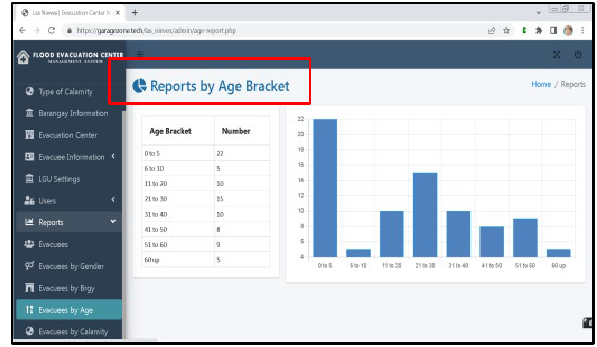
Figure 24. Reports of Evacuees by Age